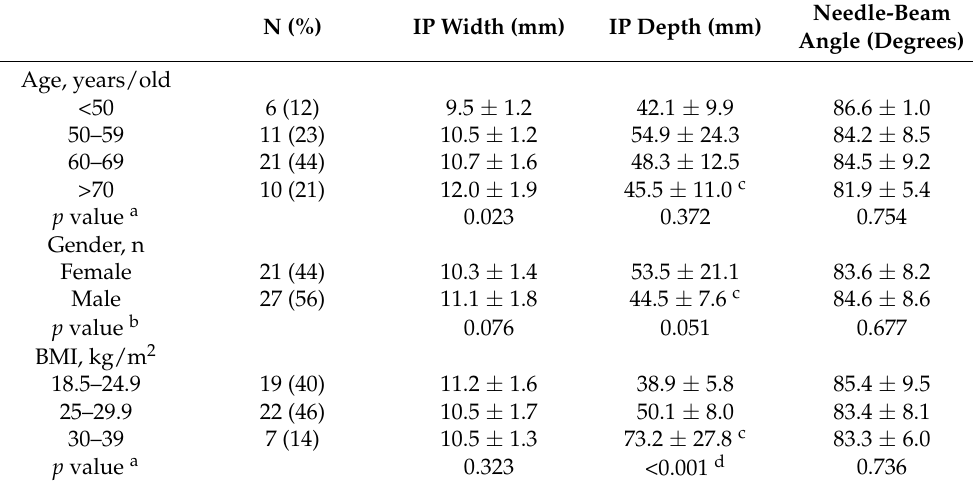
Table 1. Iliopsoas plane (IP) width, depth, and needle-beam angle (mean ± Std) shown by subgroups in the age, gender, and body mass index (BMI)